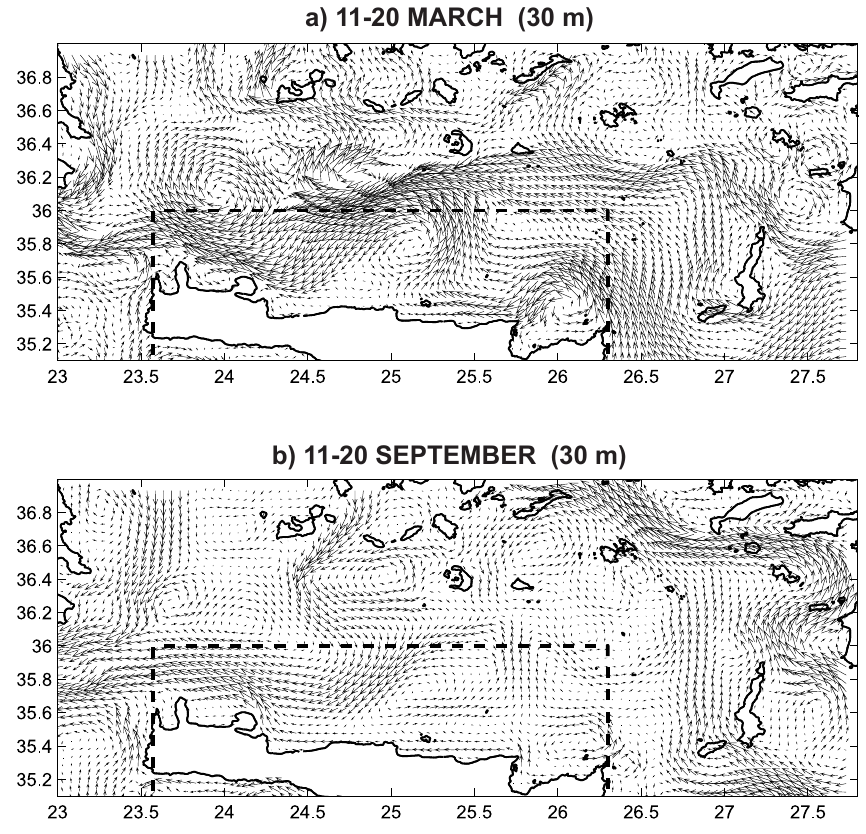
Fig. 7. (a) Winter (11–20 March) subsurface (30m) circulation pattern for the southern Aegean, corresponding to ALERMO’s climatological run (third year). Dashed line denotes Cretan Sea model domain. (b) Same as (a) but for summer (11–20